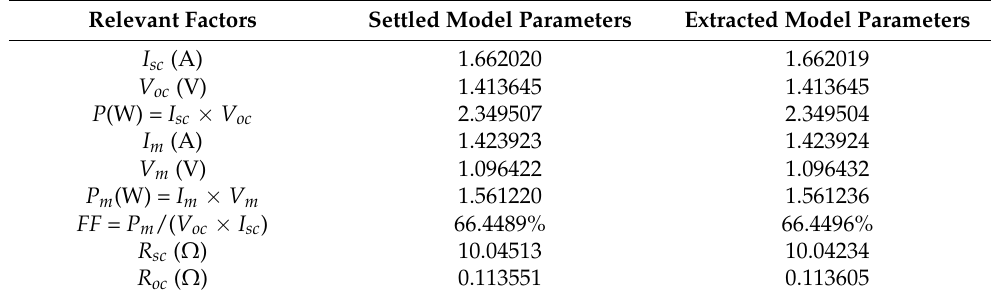
Table 2. Relevant factors in I- and P-V curves calculated by using the settled and extracted parameters.